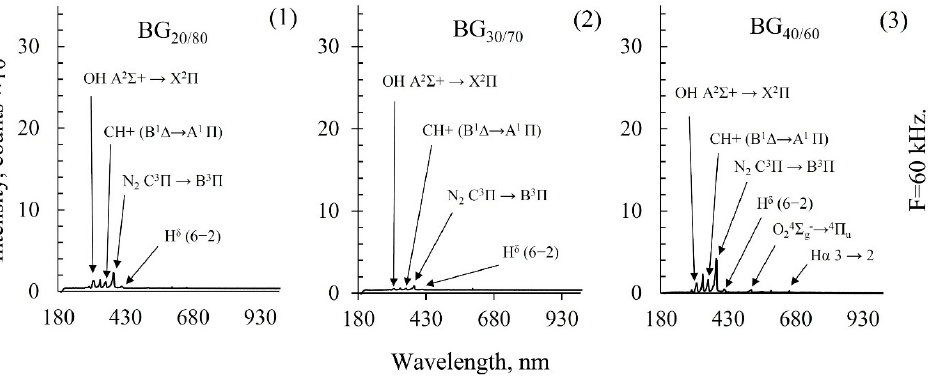
Figure 4. Emission spectrometry of biogas. U = 8300 V, F = 60 kHz, (1)—BG 20/80 , (2)—BG 30/70 , (3)—BG 40/60 .